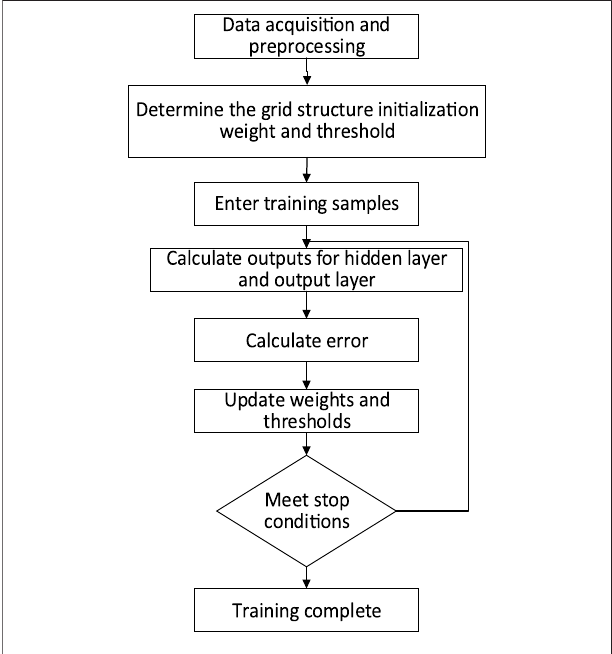
FIGURE 7 | BP model training